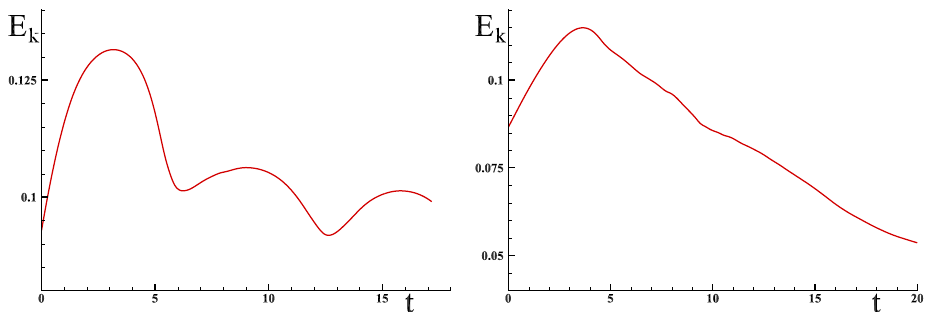
Figure 6. Evolution of the kinetic energy with time in the case of a cylinder ( left ) and for the geometry with square base ( righ